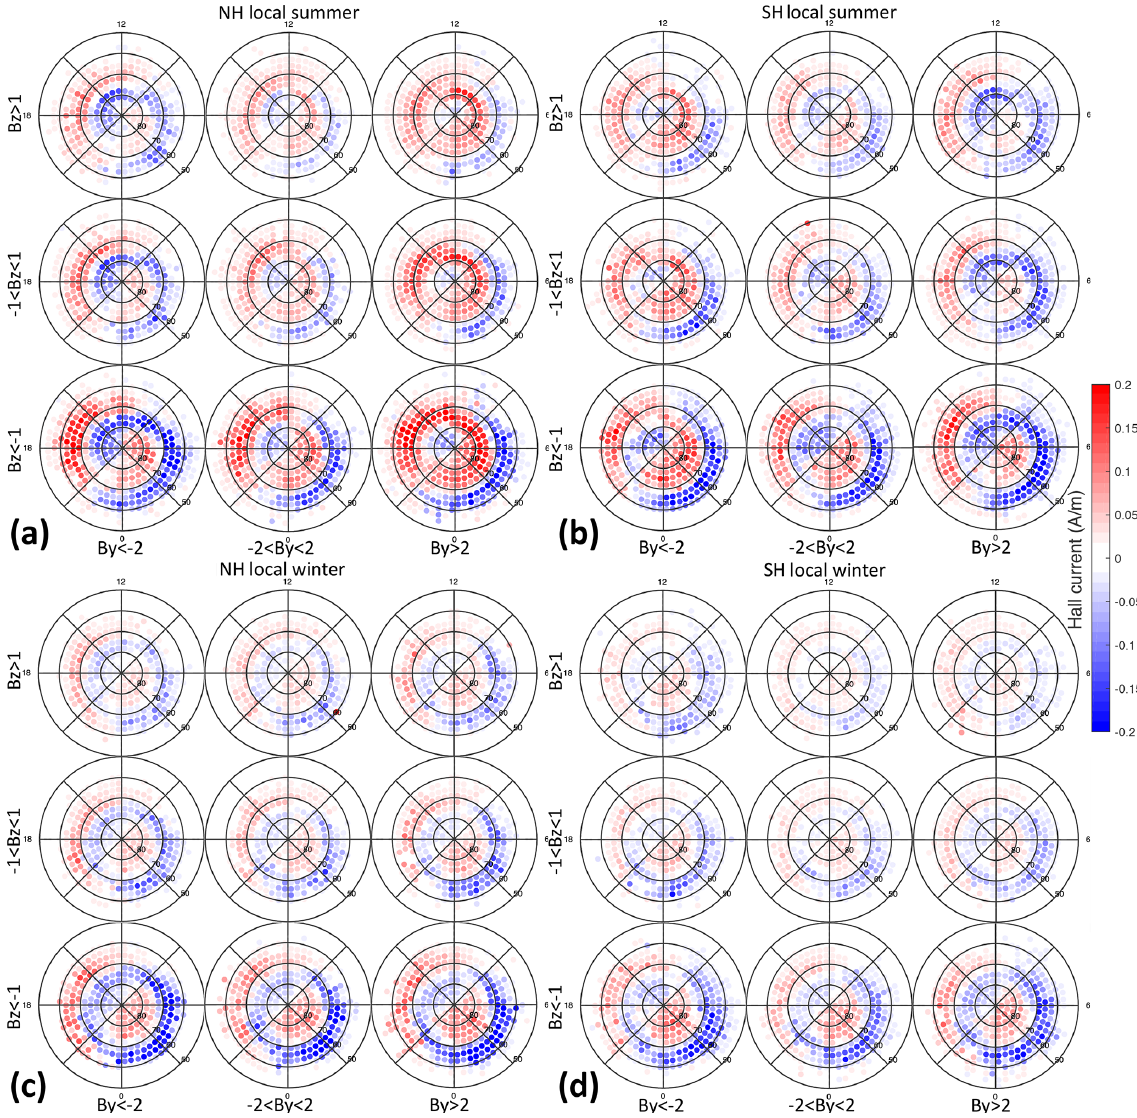
Figure 4. Maps of the average Hall current distribution in the same format as Fig. 3. The red (blue) dots represent eastward (westward) currents. Here the currents mainly flow anti-sunward along the auroral oval and sunward in the polar